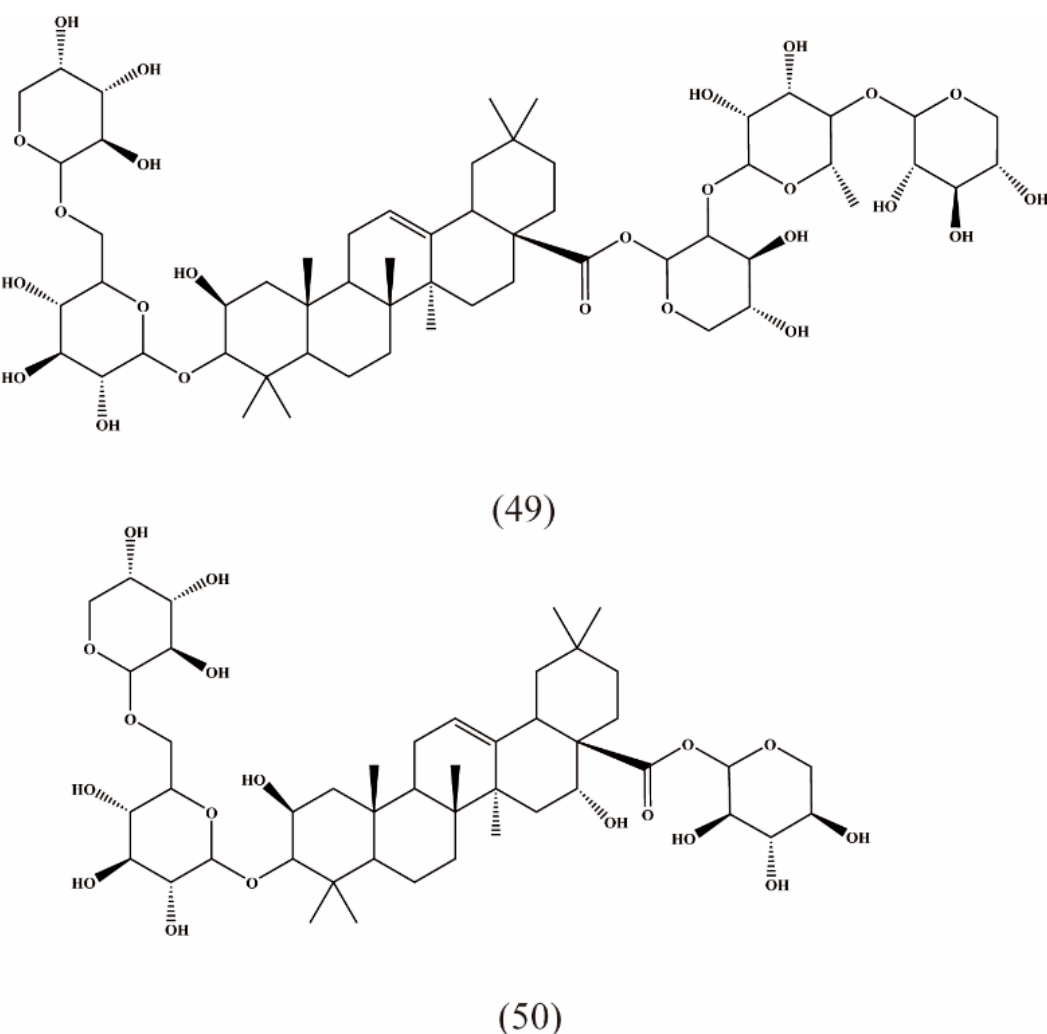
Figure 2. Structures of terpenes isolated from Radix Asteris.